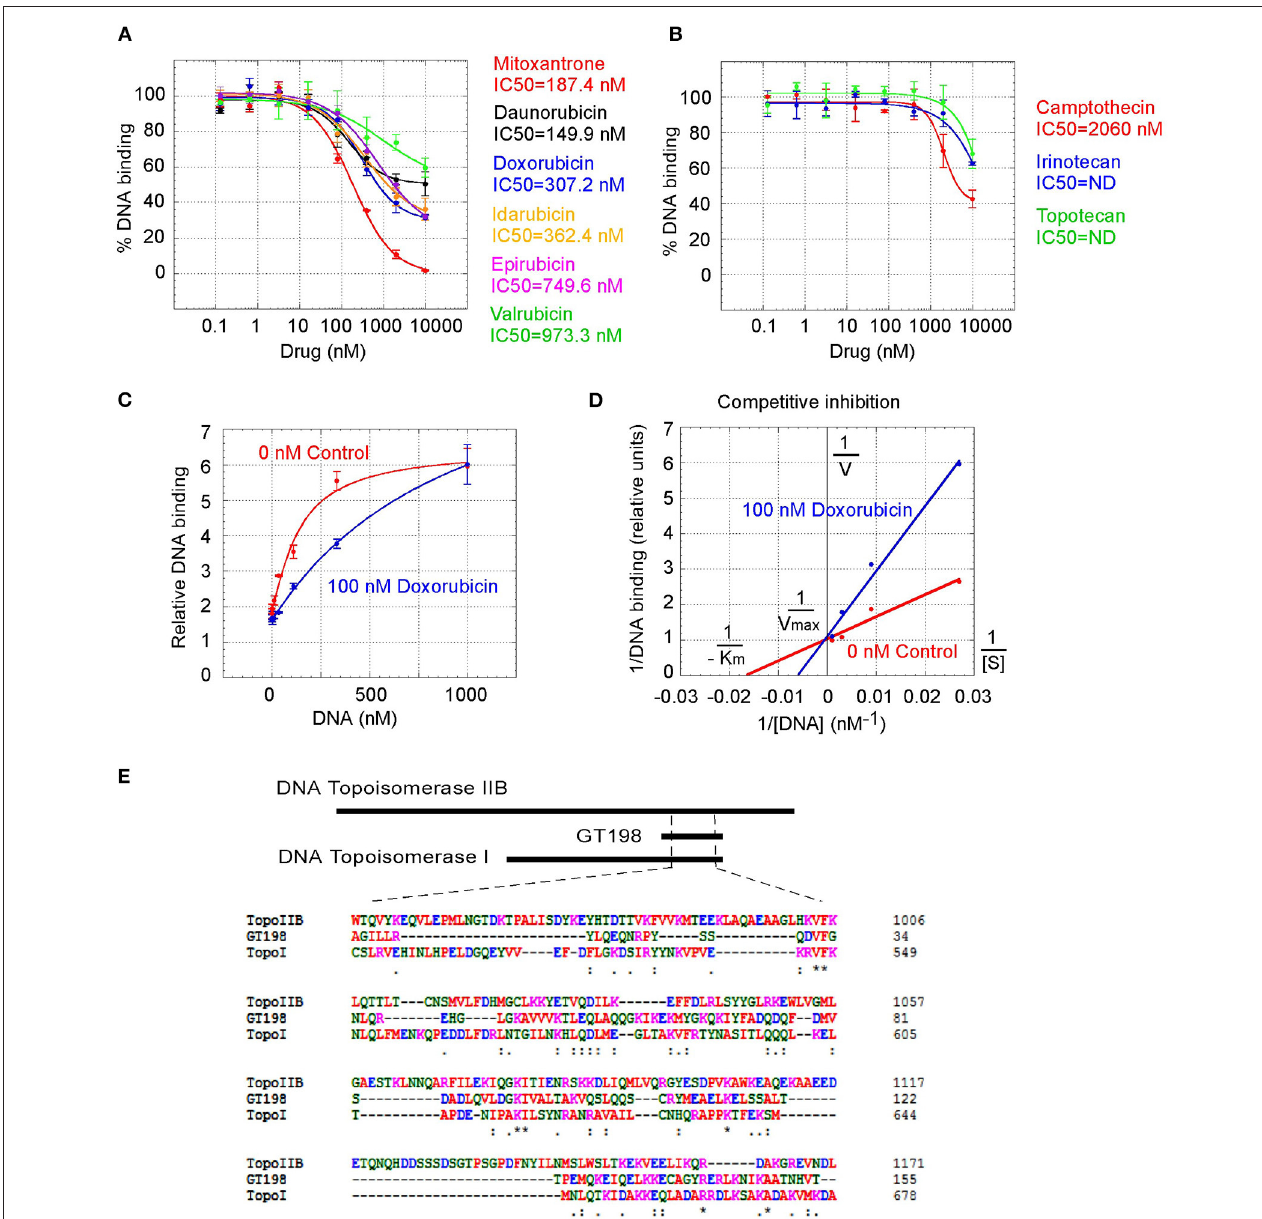
FIGURE 3 | Competitive inhibition of GT198 by doxorubicin. (A,B) Inhibition of the DNA binding to GT198 under increasing concentrations of doxorubicin analogs and camptothecin analogs. Their IC 50 s are as indicated. (C) Increasing concentrations of biotinylated DNA bind to GT198 in the presence (blue) or absence (red) of 100nM doxorubicin. Doxorubicin as a competitor shifts the binding curve to the right. (D) Double reciprocal plot using the means of high-concentration data points (37, 111, 333, 1,000nM) from the panel C. The constant Vmax and increased Km with doxorubicin indicate competitive inhibition. (E) Primary sequence homology among human GT198 and DNA topoisomerase I and IIB (Clustal Omega). Asterisks denote identical residues and dots denote homologous residues. Full-length alignment is shown in Supplementary Figure 2